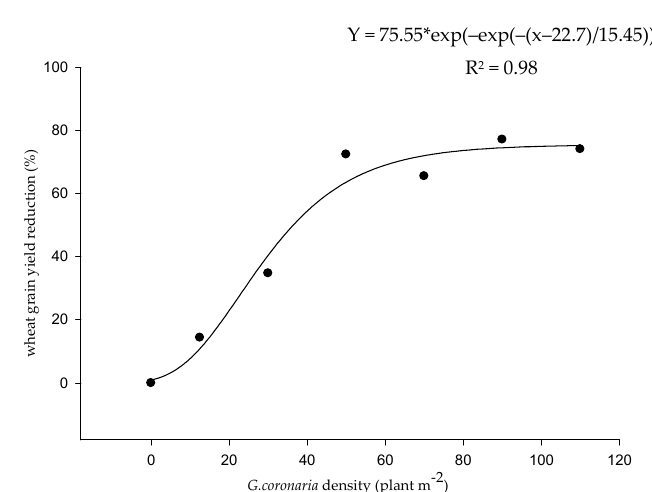
ff ect of G. coronaria density on wheat grain yield reduction Figure 1. Effect of G. coronaria density on wheat grain yield reduction (%). Figure 1. E